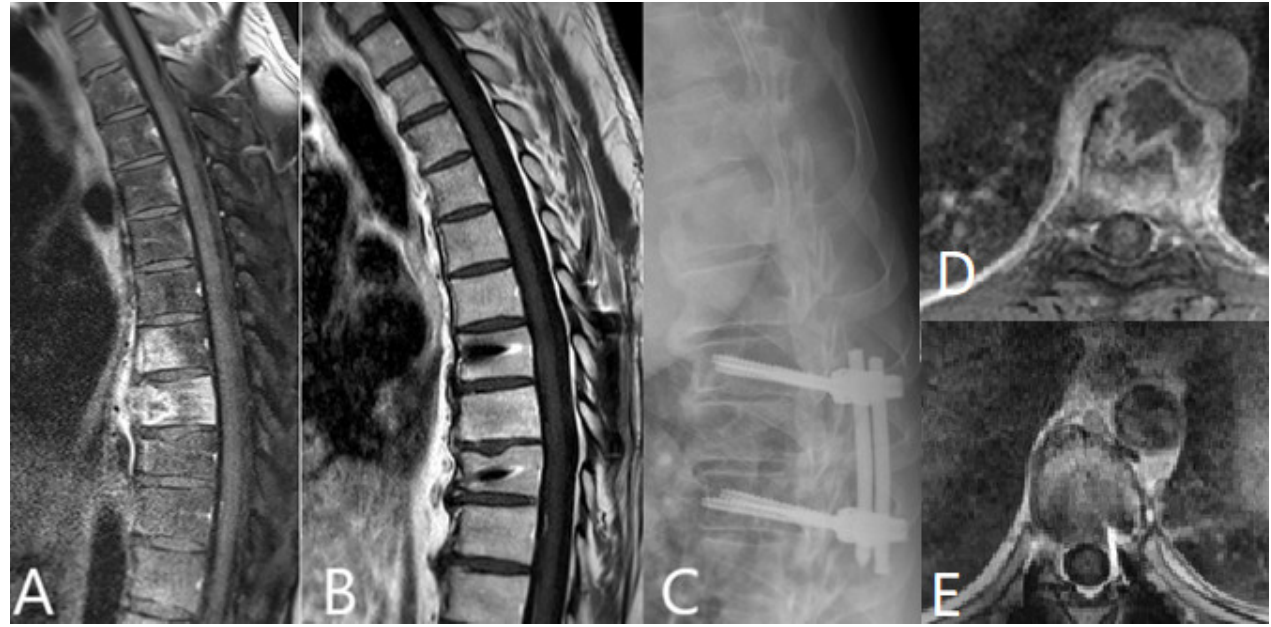
Figure 2. 44-year-old male patient with spondylodiscitis of the thoracic spine due to an infection with Mycobacterium tuberculosis . ( A ). preoperative T1 post-contrast MRI of the thoracic spine shows spondylodiscitis in Th 7/8 and Th 8/9. ( B ). postoperative T1 post-contrast of the thoracic spine shows the complete resolution of the infection 6 months following surgery. ( C ). postoperative X-ray of the thoracic spine shows the spinal construct with screws and rods in T7-T9. ( D ). Axial T1-weighted post-contrast MRI of the spine at Th7 level shows infection predominantly in ventral portion of the vertebral body. ( E ). T1-weighted post-contrast MRI of the spine at Th7 level 6 months following surgery shows complete resolution of the infection.